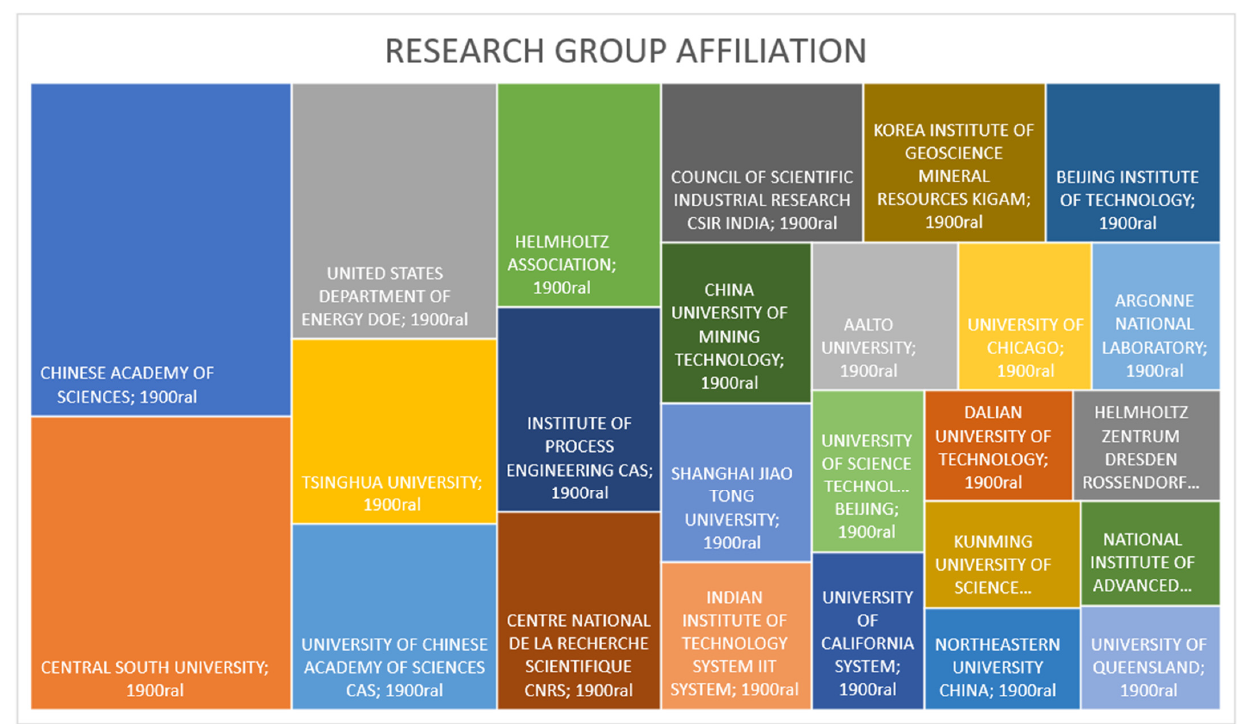
Figure 7. LIB research group affiliation—top 25 groups with most publications in the LIB research field.